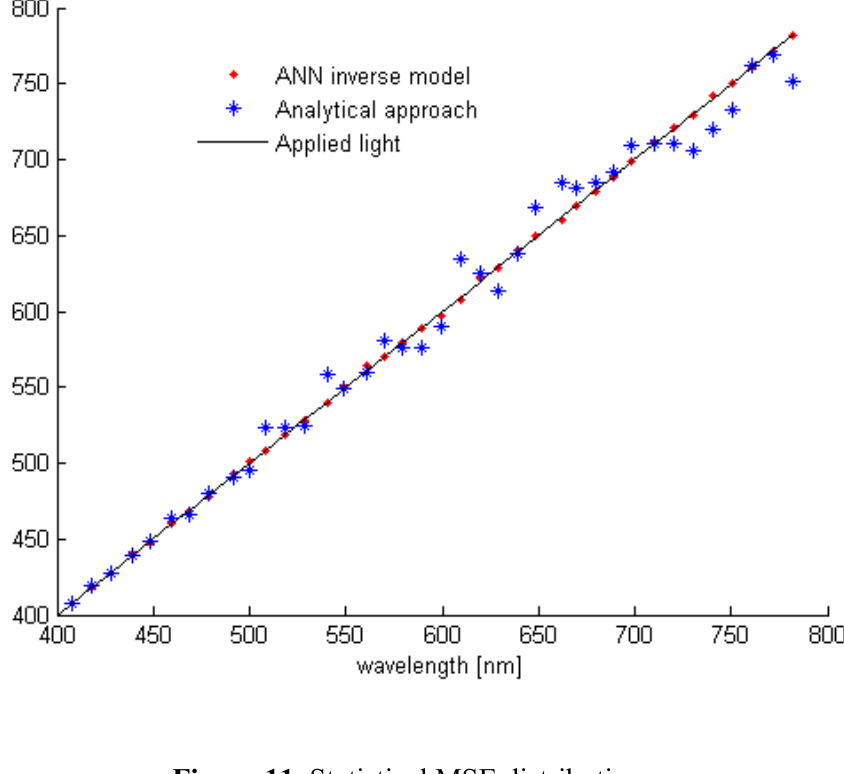
Figure 11. Statistical MSE